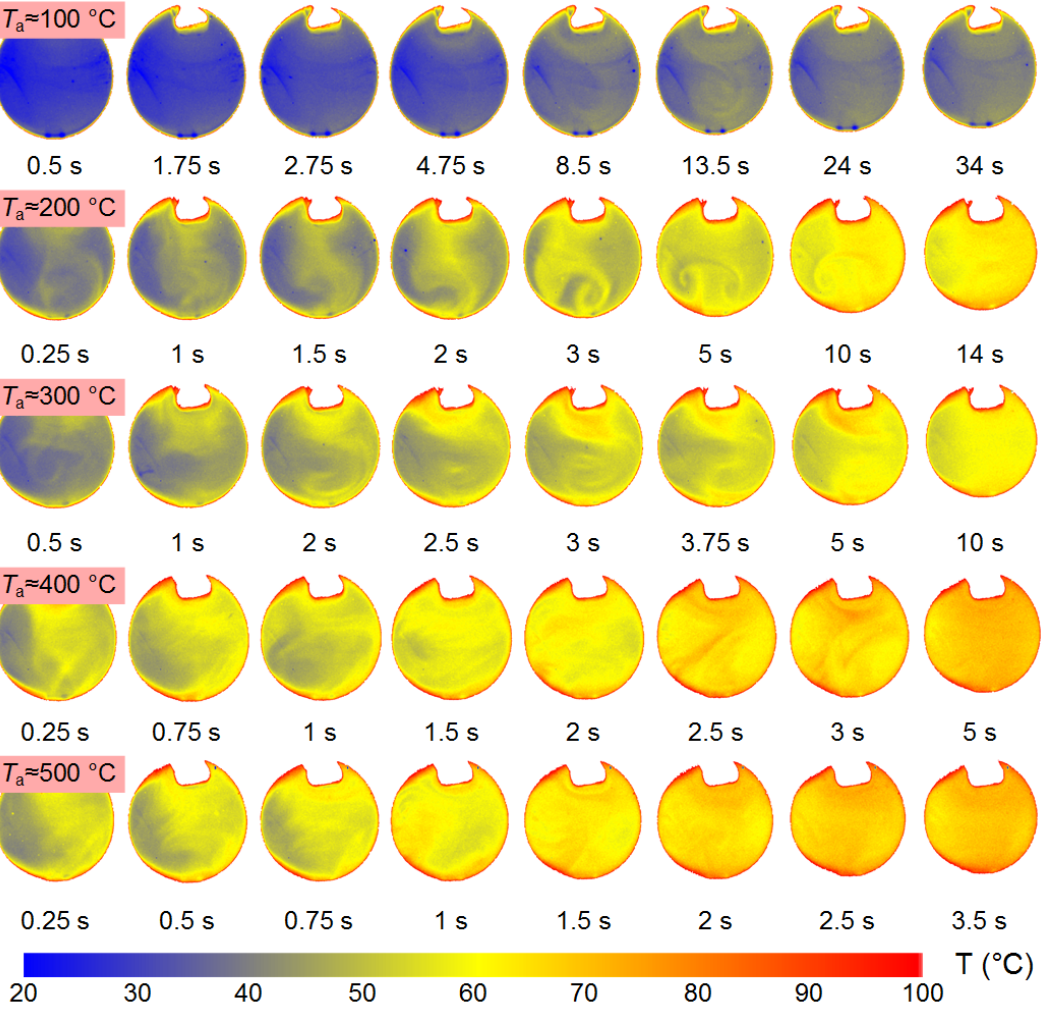
Figure 9. Temperature fields for suspended spherical water droplets ( R d ≈ 1.6 mm) in hot air flow ( U a ≈ 3 m/s) with temperature in the range of T a = 100–500 °C.